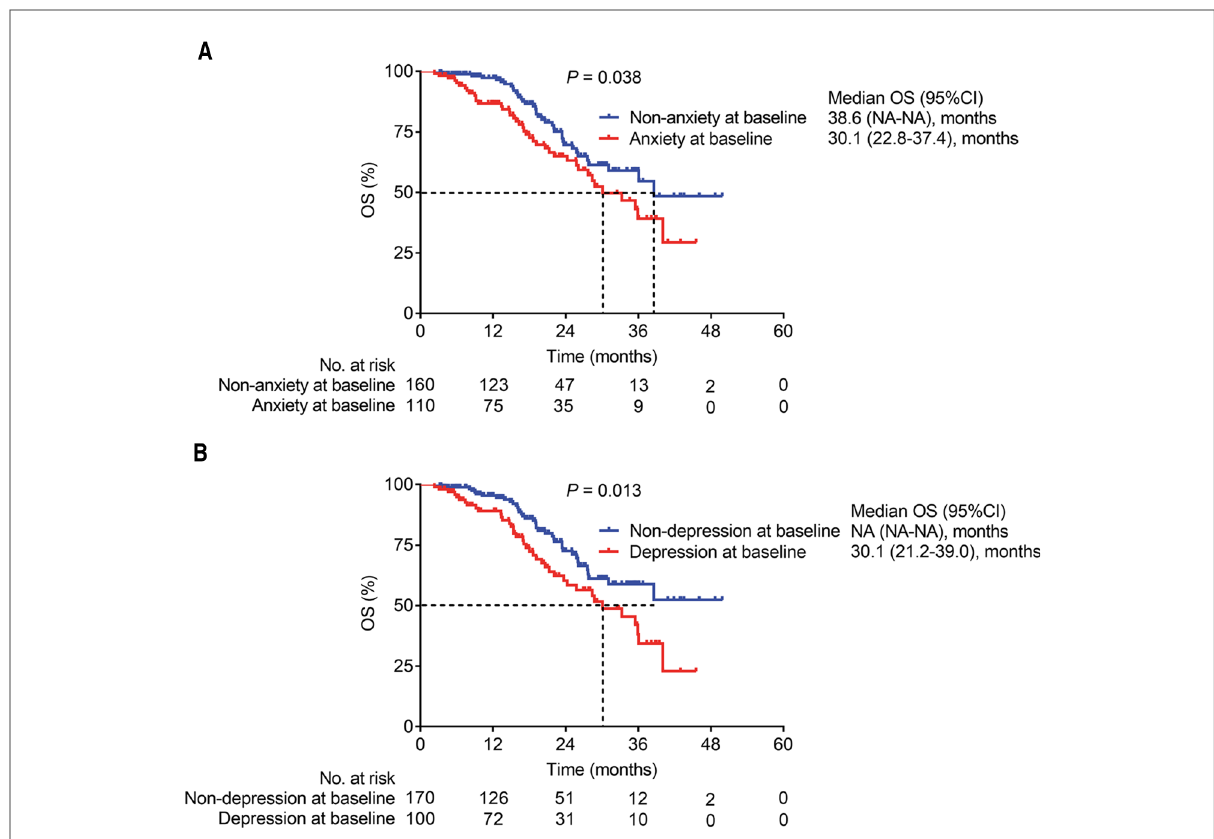
FIGURE 2 The relationship of anxiety and depression with OS in glioma patients. OS in glioma patients with anxiety and those without anxiety at baseline ( A ); and OS in glioma patients with depression and those without depression at baseline ( B